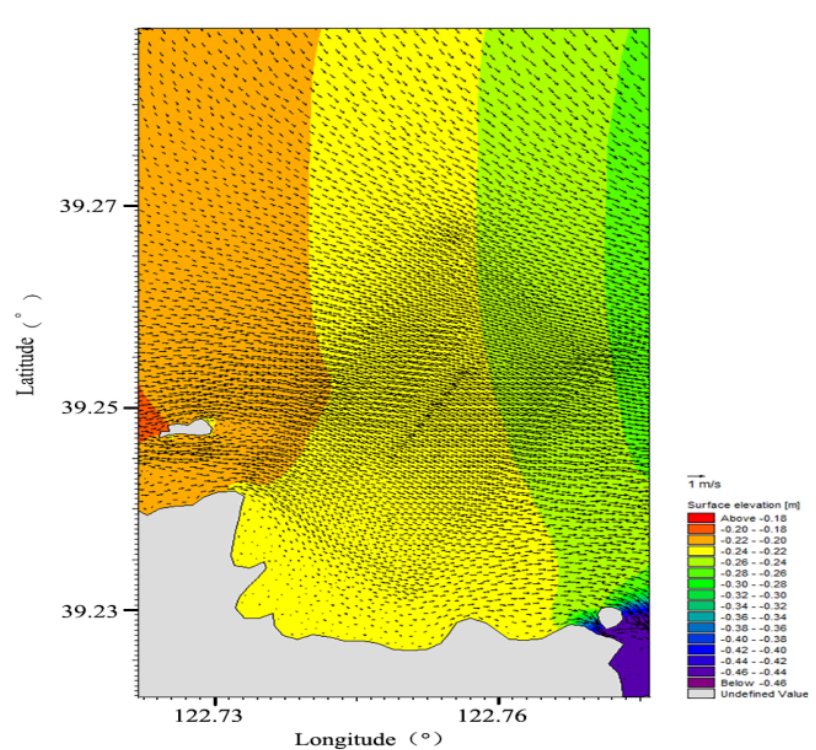
Figure 10. Flow field distribution at the peak of an ebb tide.